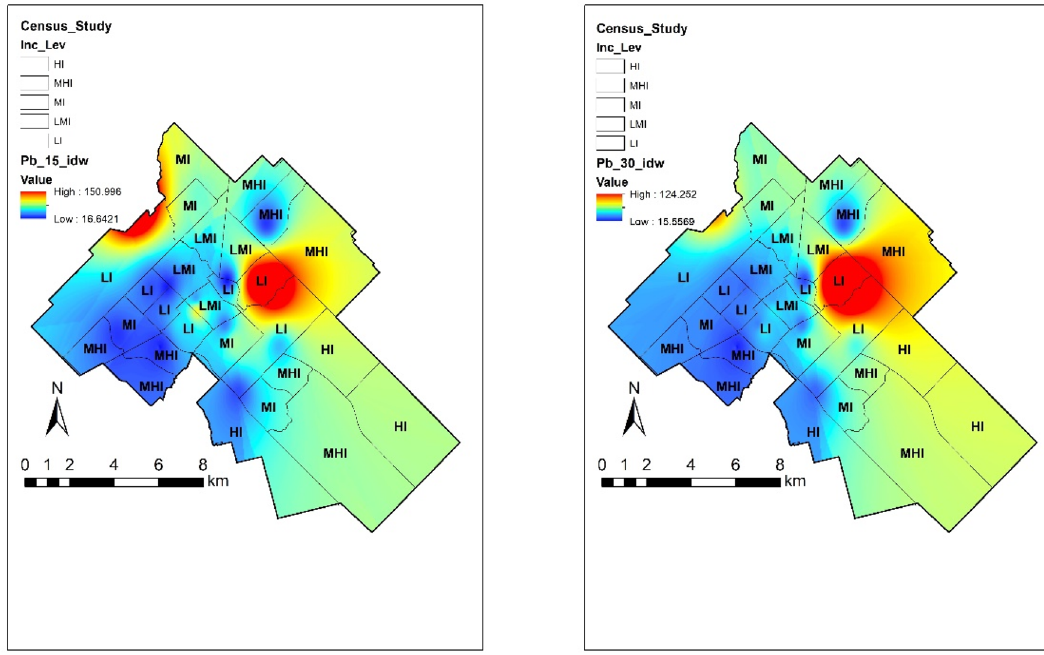
Figure 4. Concentration of Pb around the city in relation with income. The map was prepared by using the “Geostatistical Analyst” tool in ArcGIS 10.4 (https:// deskt op. arcgis. com/ en/).